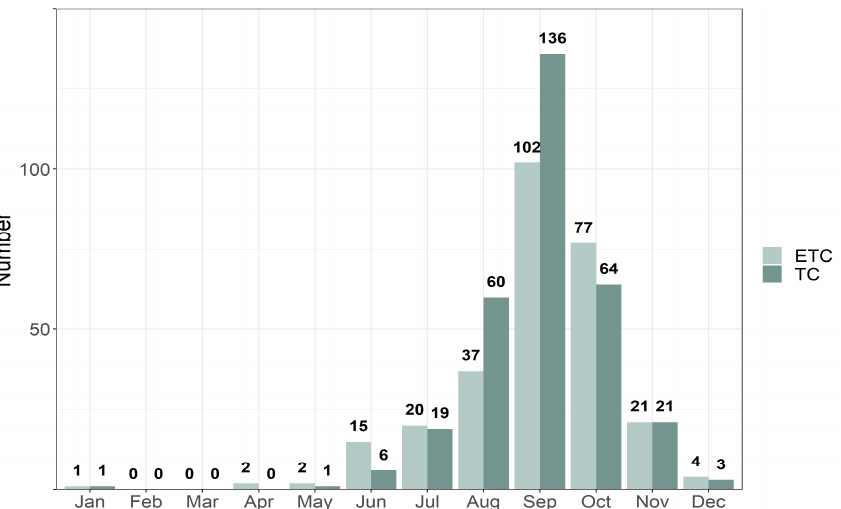
Figure 1. Total monthly abundance of hurricanes (TCs) and extratropical cyclones (ETCs) in the years 1970–2019.